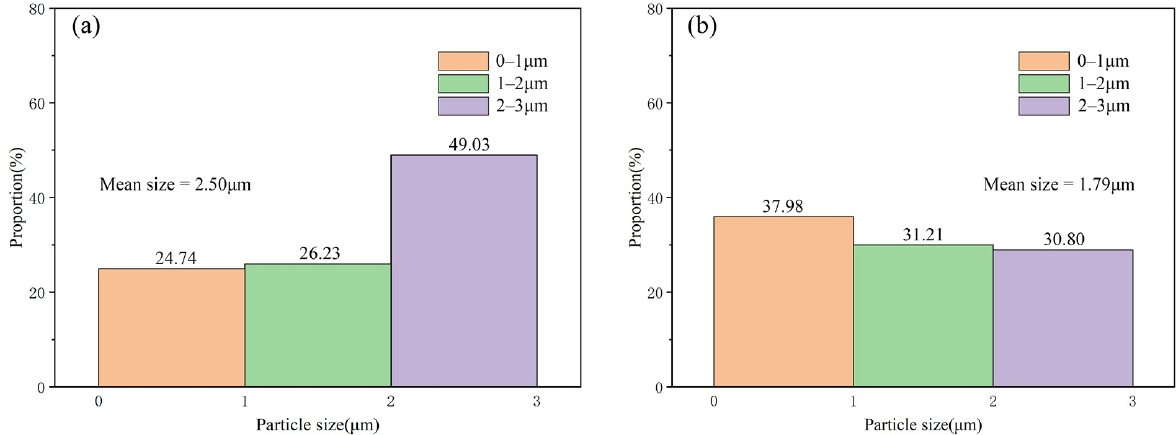
Figure 12. The size and its distribution of TiC in the composites prepared by different diamond sizes: ( a ) 10 μ m diamond and ( b ) 6 μ m diamond.